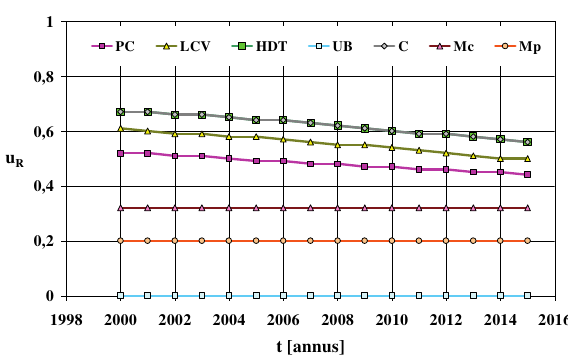
Fig. 4. Share of mileage by vehicles per cumulated category, under model traffic conditions: